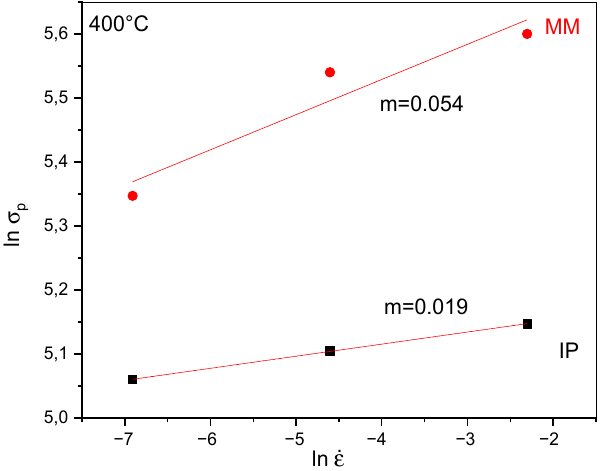
Figure 8. Example of the determination of strain rate sensitivity at 400 °C. Table 2. Values of strain rate sensitivity (m) of IP and MM.